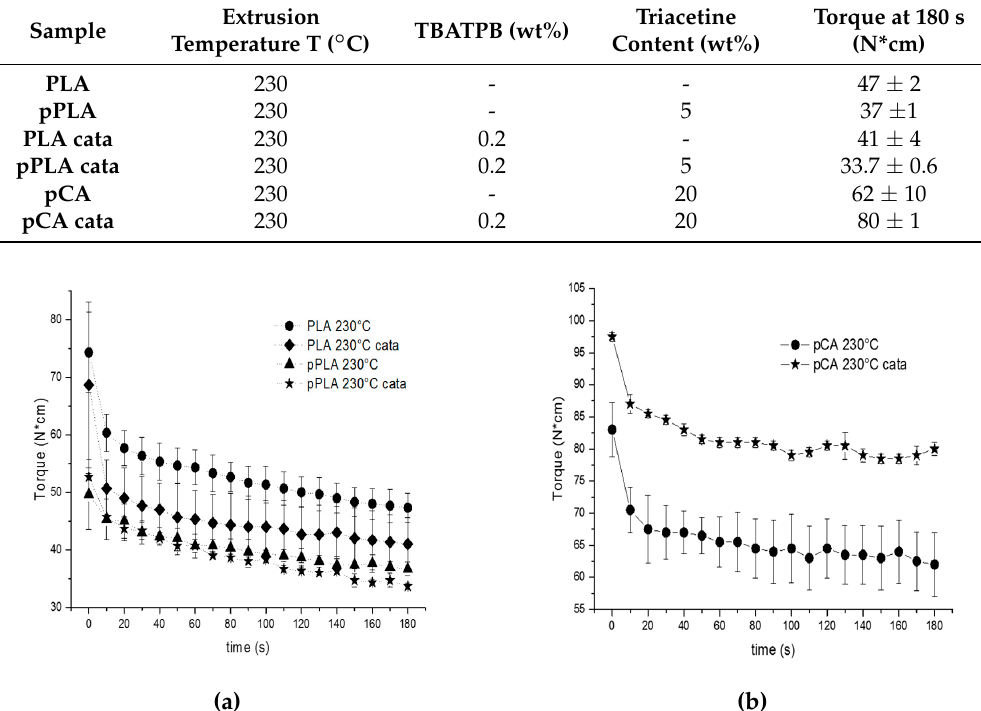
Table 2. Reference extrusion experiments carried out at 230 ◦ C. pPLA = plasticized PLA; N*cm = N · cm.